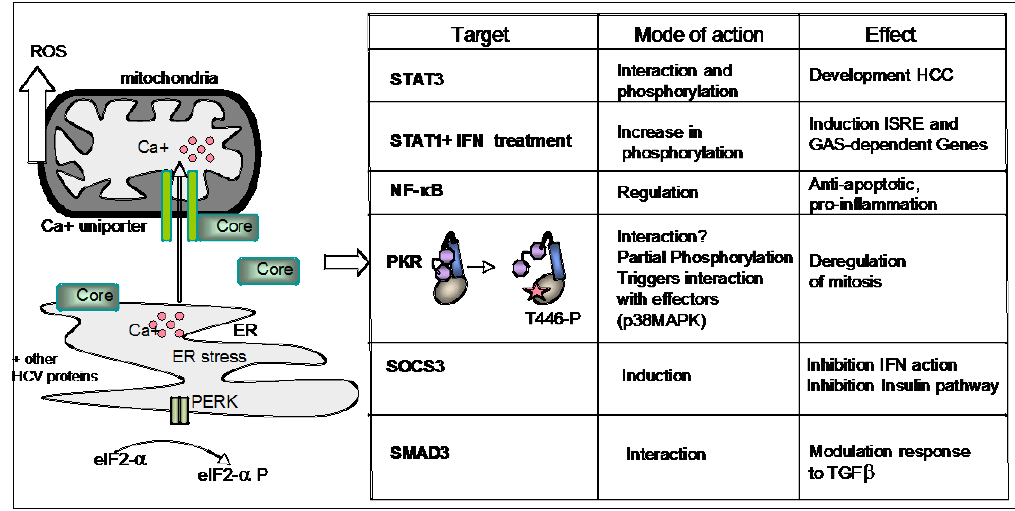
Figure 5. PKR and the HCV core protein. After translation from the HCV RNA, the HCV proteins, including the core protein, interact with the membrane of the endoplasmic reticulum (ER). Accumulation of the core protein at the ER triggers an ER stress which can lead to a PERK-mediated eIF2 α phosphorylation and also a release of calcium (Ca+). The core protein binds also to the outer membrane of mitochondria where it stimulates the Calcium uniporter, thus allowing calcium uptake and generation of Reactive Oxygen Species (ROS). The core protein interacts with multiple cellular proteins and affects a number of signaling pathways. Some of its targets are shown in the left table, with indications of its mode of action and effect on the cells. The core protein interacts with PKR to trigger its partial phosphorylation (on threonine 446) which may change the conformation of PKR and favor its interaction with other partners such as